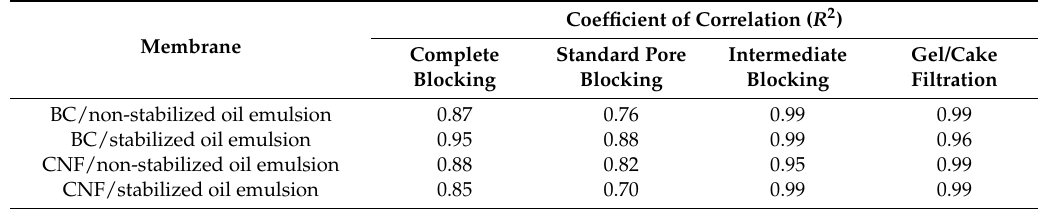
Table 3. Coefficient of correlation ( R 2 ) values for different fouling models for the filtration of oil–water emulsion by BC and CNF membranes.